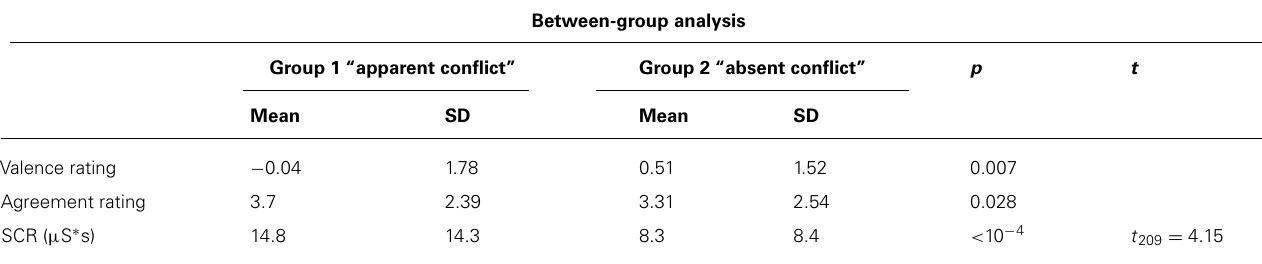
Table 2 | Comparison of valence and agreement ratings and skin conductance reactivity between group 1 with “apparent conflict” and group 2 with “absent conflict.”